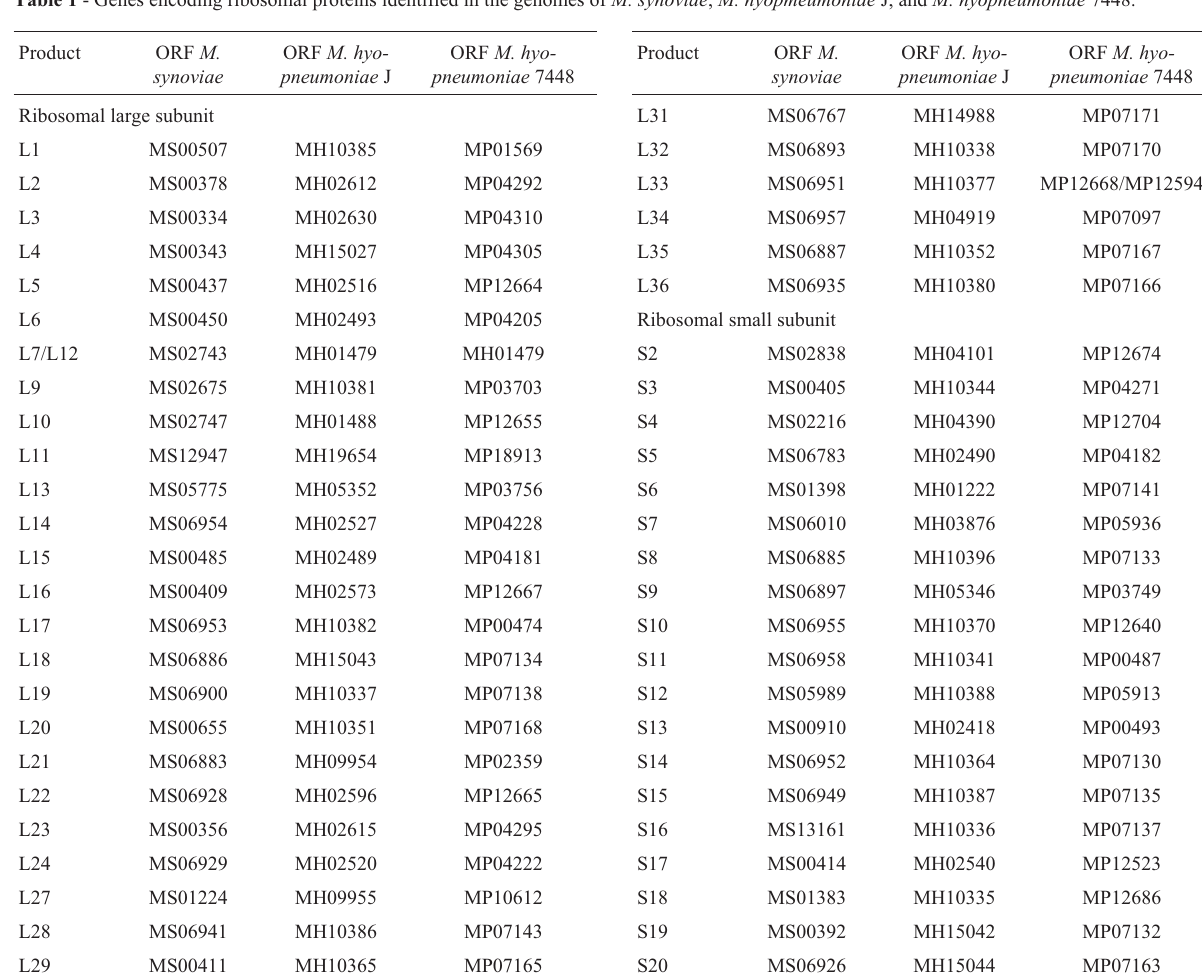
Table 1 - Genes encoding ribosomal proteins identified in the genomes of M. synoviae , M. hyopmeumoniae J, and M. hyopneumoniae